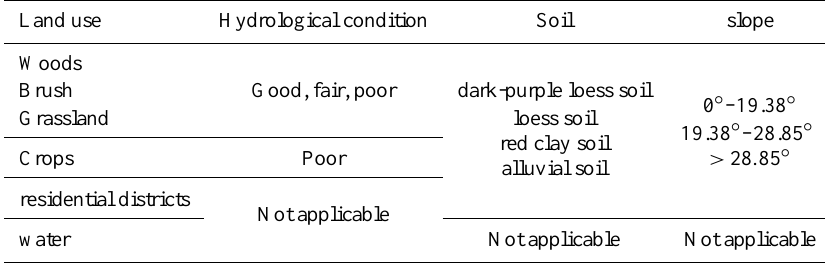
Table 3. Detail factors for land type unit